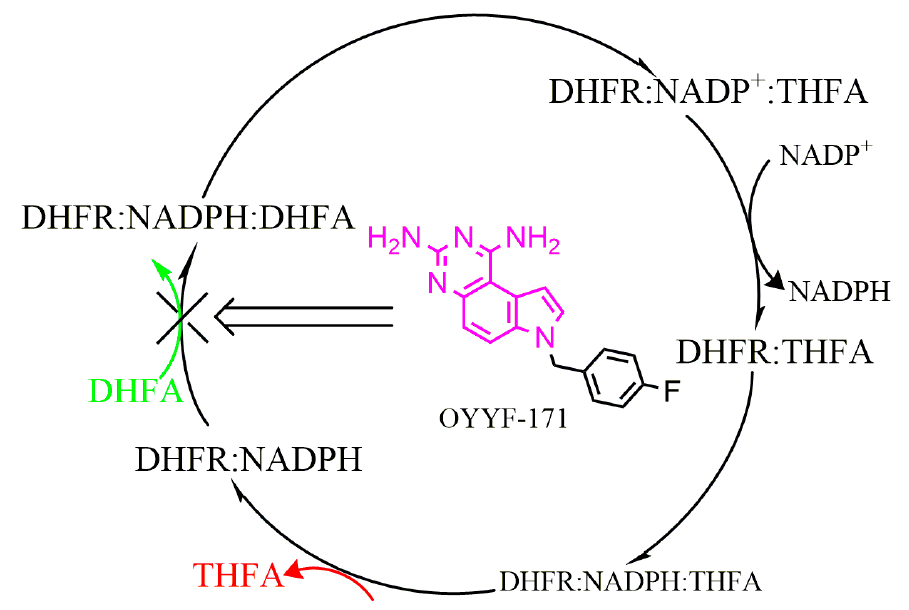
Figure 1. Catalytic cycle of DHFR.